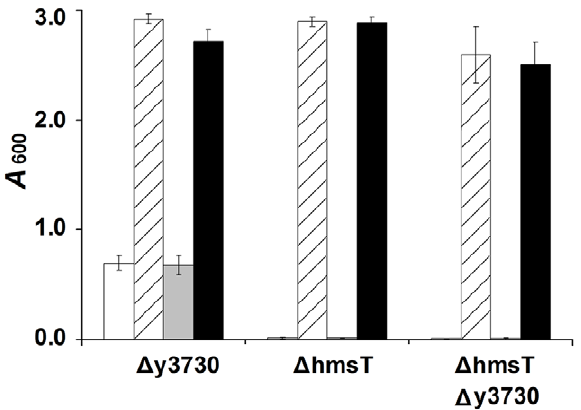
Figure 3. Relative amount of invitro biofilm made by the Y. pestis y3730, hmsT , and y3730 hmsT mutant strains after transformation with the empty plasmid vector, (white bars) or the plasmid containing wild-type y3730 (hatched bars), mutated y3730 (grey bars), or hmsT (black bars). The mean and standard deviation of two or more independent experiments are indicated.